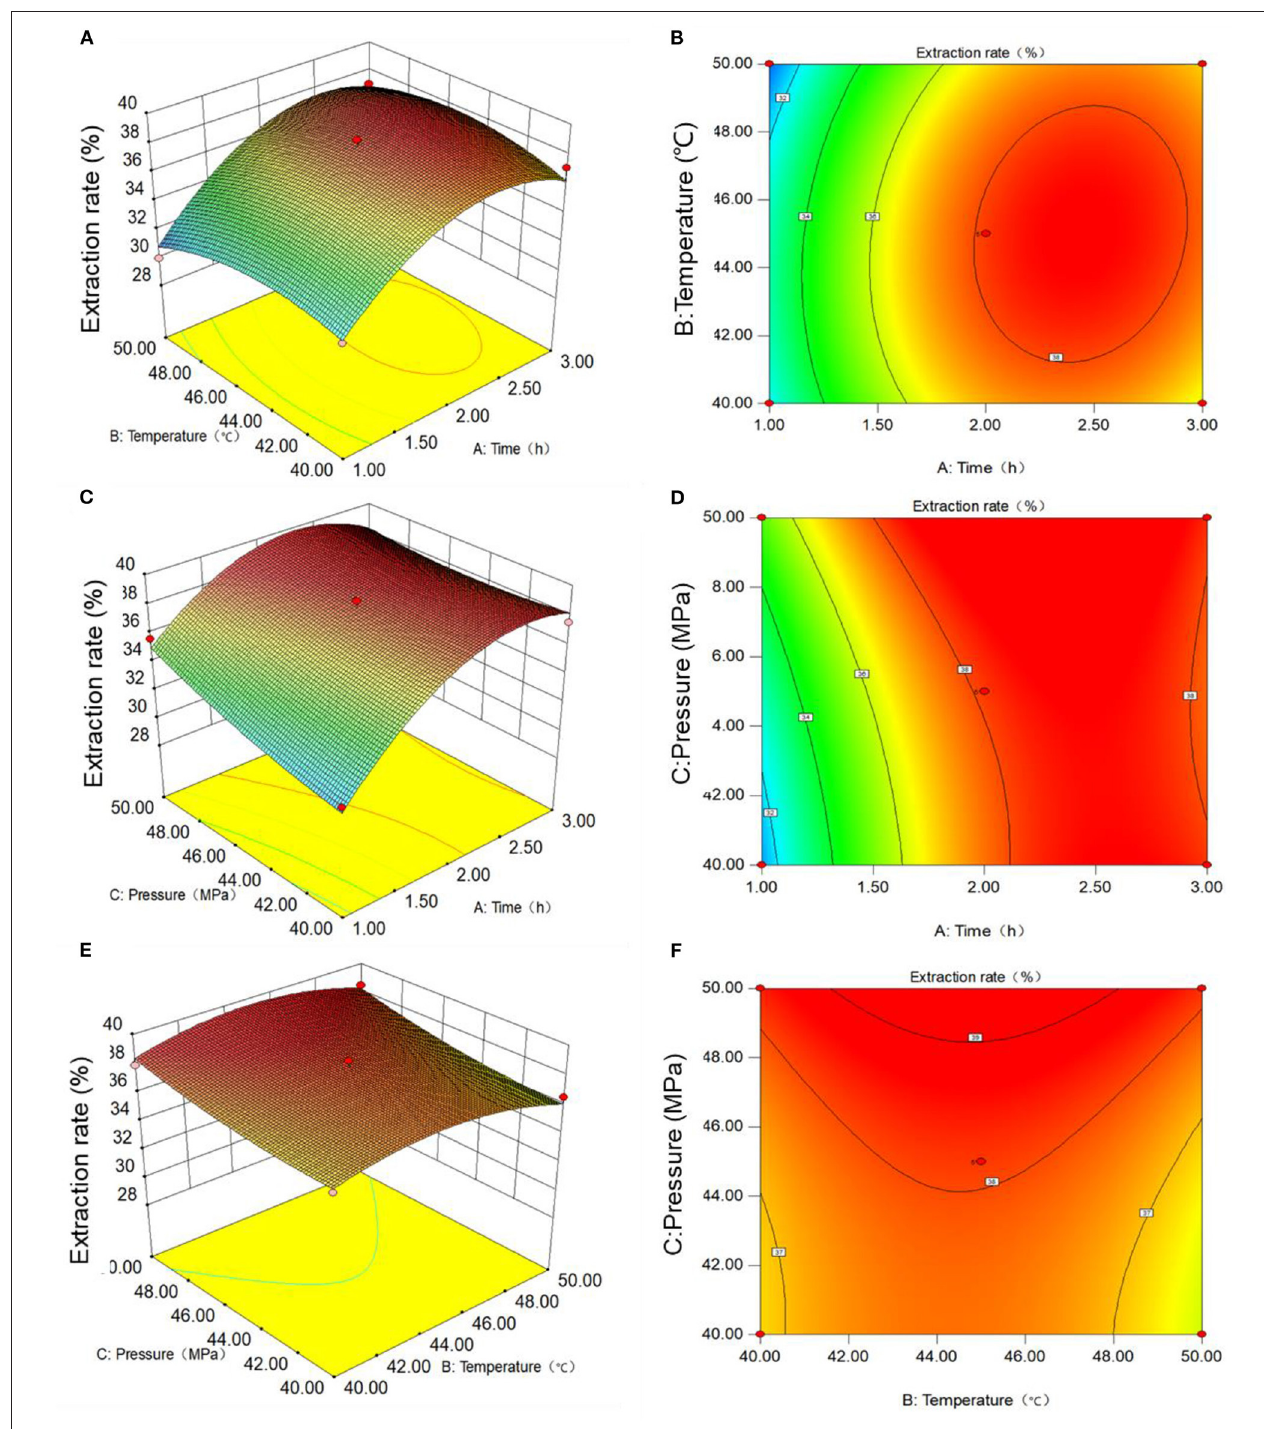
FIGURE 2 | Response surface and contour plots showing the interactive effect of different extraction conditions on the extraction efficiency of Moringa seed oil: (A,B) temperature and time; (C,D) temperature and pressure; (E,F) time and pressure.